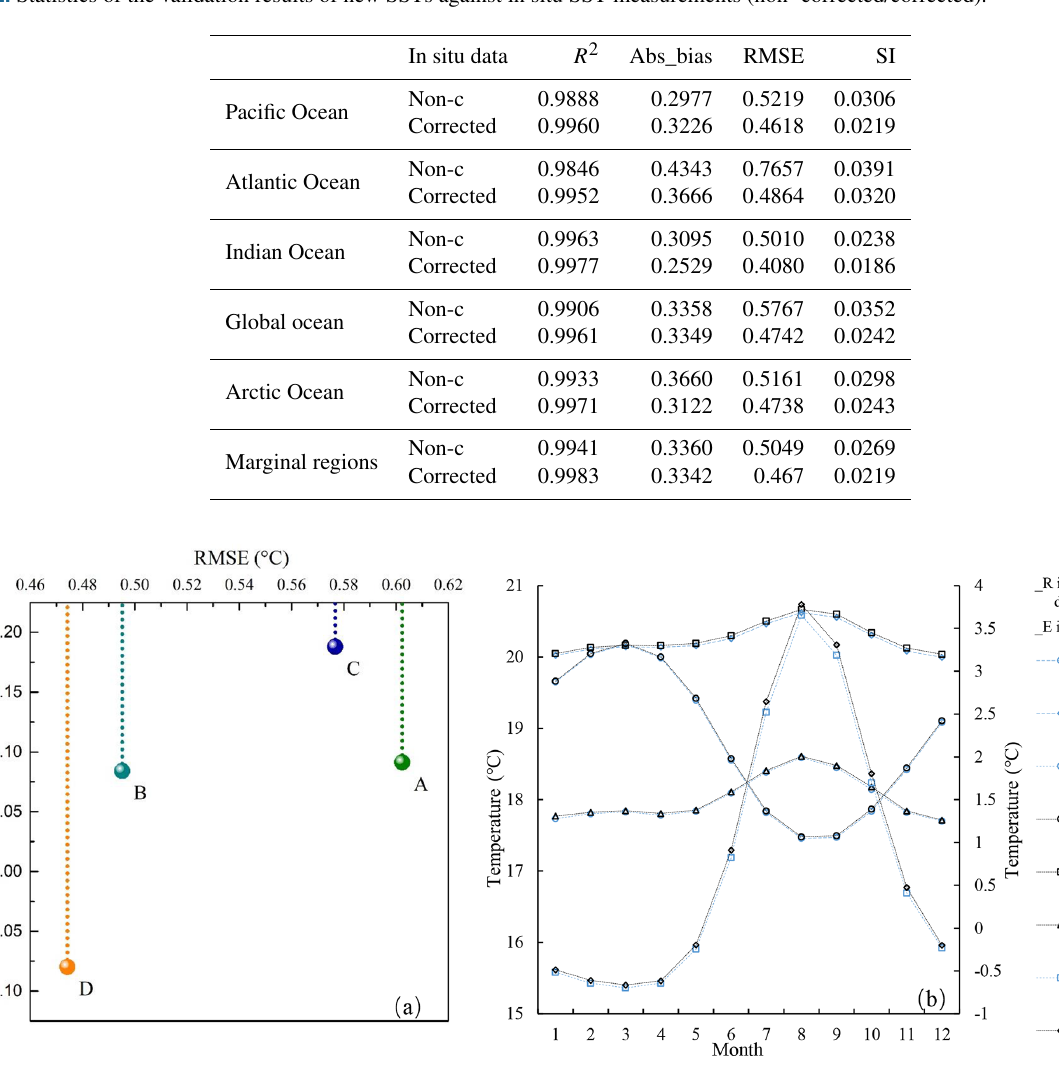
Table 2. Statistics of the validation results of new SSTs against in situ SST measurements (non- corrected/corrected).